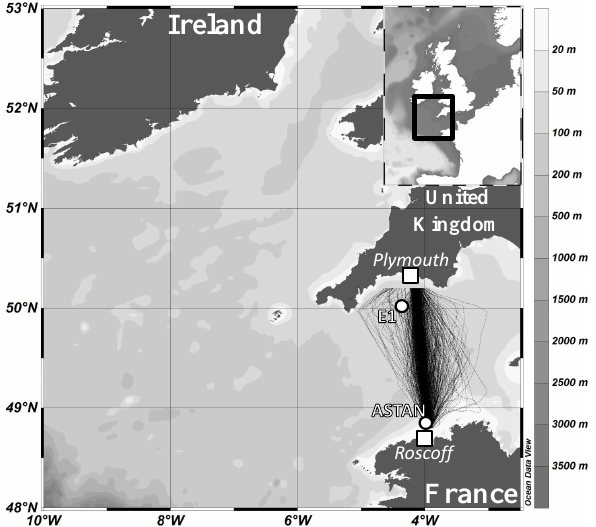
Figure 1. Map and bathymetry of the study area with the tracks of all crossings made from 2011 to 2013 by the ferry Armorique be- tween Roscoff (France) and Plymouth (UK). The locations of fixed stations E1 (Western Channel Observatory) and ASTAN (coastal observatory SOMLIT) are also indicated.